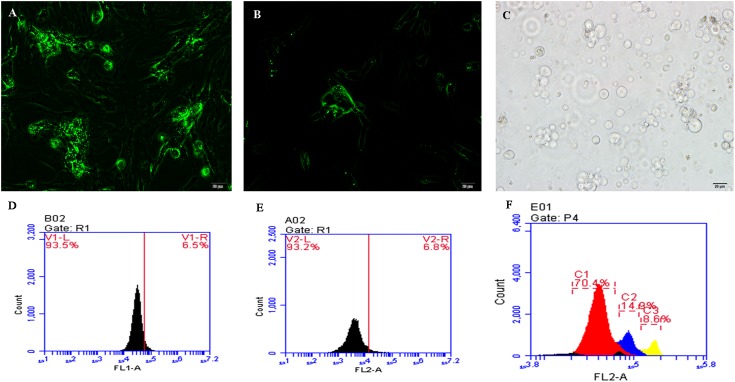
Cell sorting via flow cytometry.(A) The primordial germ cells (PGCs) were identified with a c-Kit antibody marked with FITC (200×). (B) The spermatogonial stem cells (SSCs) were marked with an Integrin alpha 6 antibody with FITC (200×). Both PGCs and SSCs were cultured for 48 h. (C) The spermatogonial (Sp) cells were directly isolated from testes and identified under light microscopy (200×). Scale bar = 20 μm. (D-F) Flow cytometry sorting for PGCs (D), SSCs (E), and Sp cells (F). The PGC, SSC, and Sp sorting ratios were 6.5%, 6.8%, and 14.9% respectively. Sp cells were stained with DAPI.